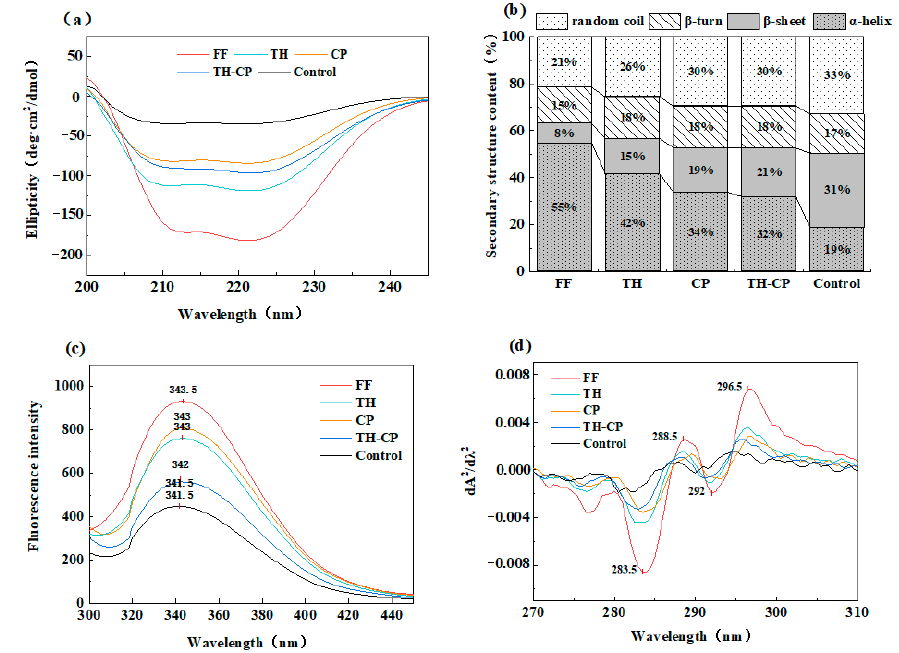
Figure 4. ( a ) Circular dichroism, ( b ) secondary structure content, ( c ) fluorescence spectrum, and ( d ) UV second derivative of myofibrillar proteins induced by freeze-thaw cycles under different treat- ments.